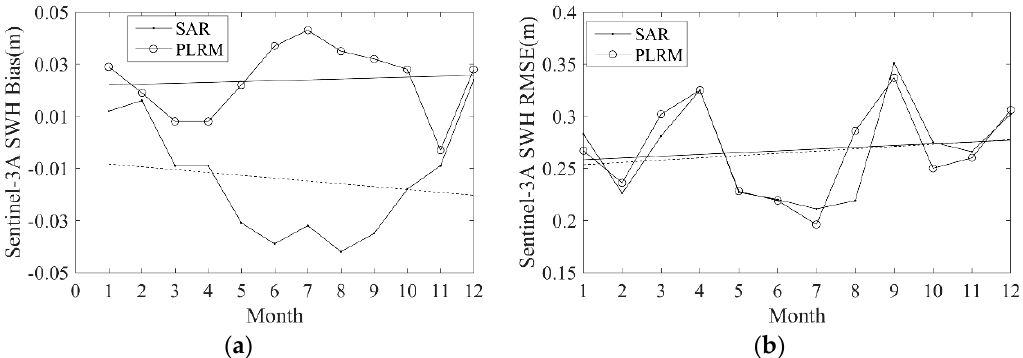
Figure 13. Monthly ( a ) bias and ( b ) RMSE of Sentinel-3A SWH in the different months of a year; the solid and dotted straight lines are the fitting trends.